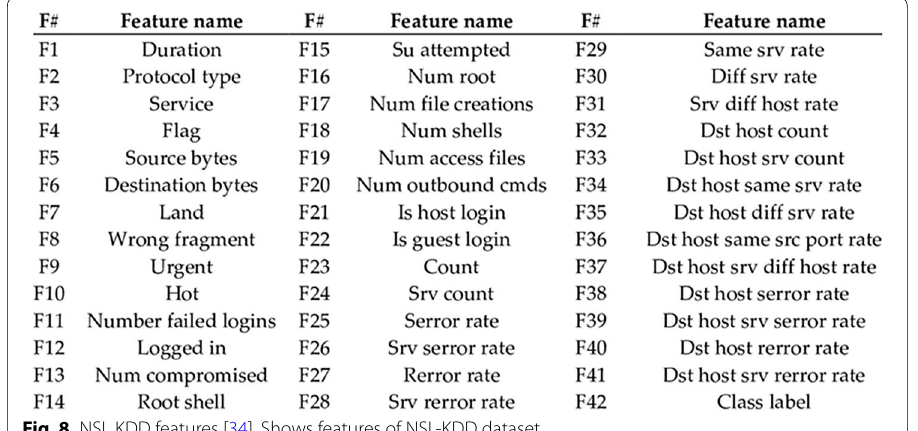
Fig. 8 NSL KDD features [34]. Shows features of NSL-KDD